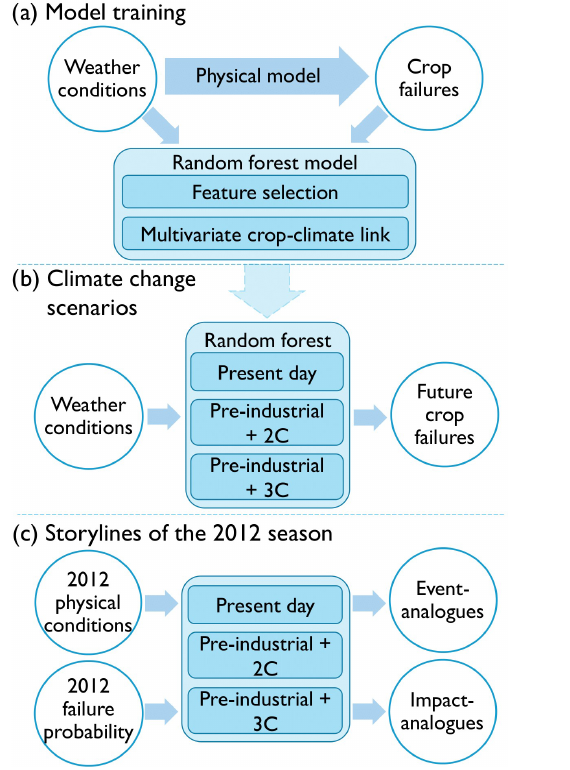
Figure 1. Experimental outline for this work. (a) Model training: the process of training a random forest model to link multiple local meteorological variables to crop failures. (b) Climate change sce- narios: the extension of the trained random forest model for global warming scenarios to predict future soybean failure ratios. (c) Sto- rylines of the 2012 season: construction of analogues to the 2012 season using two different approaches: the event analogues and the impact